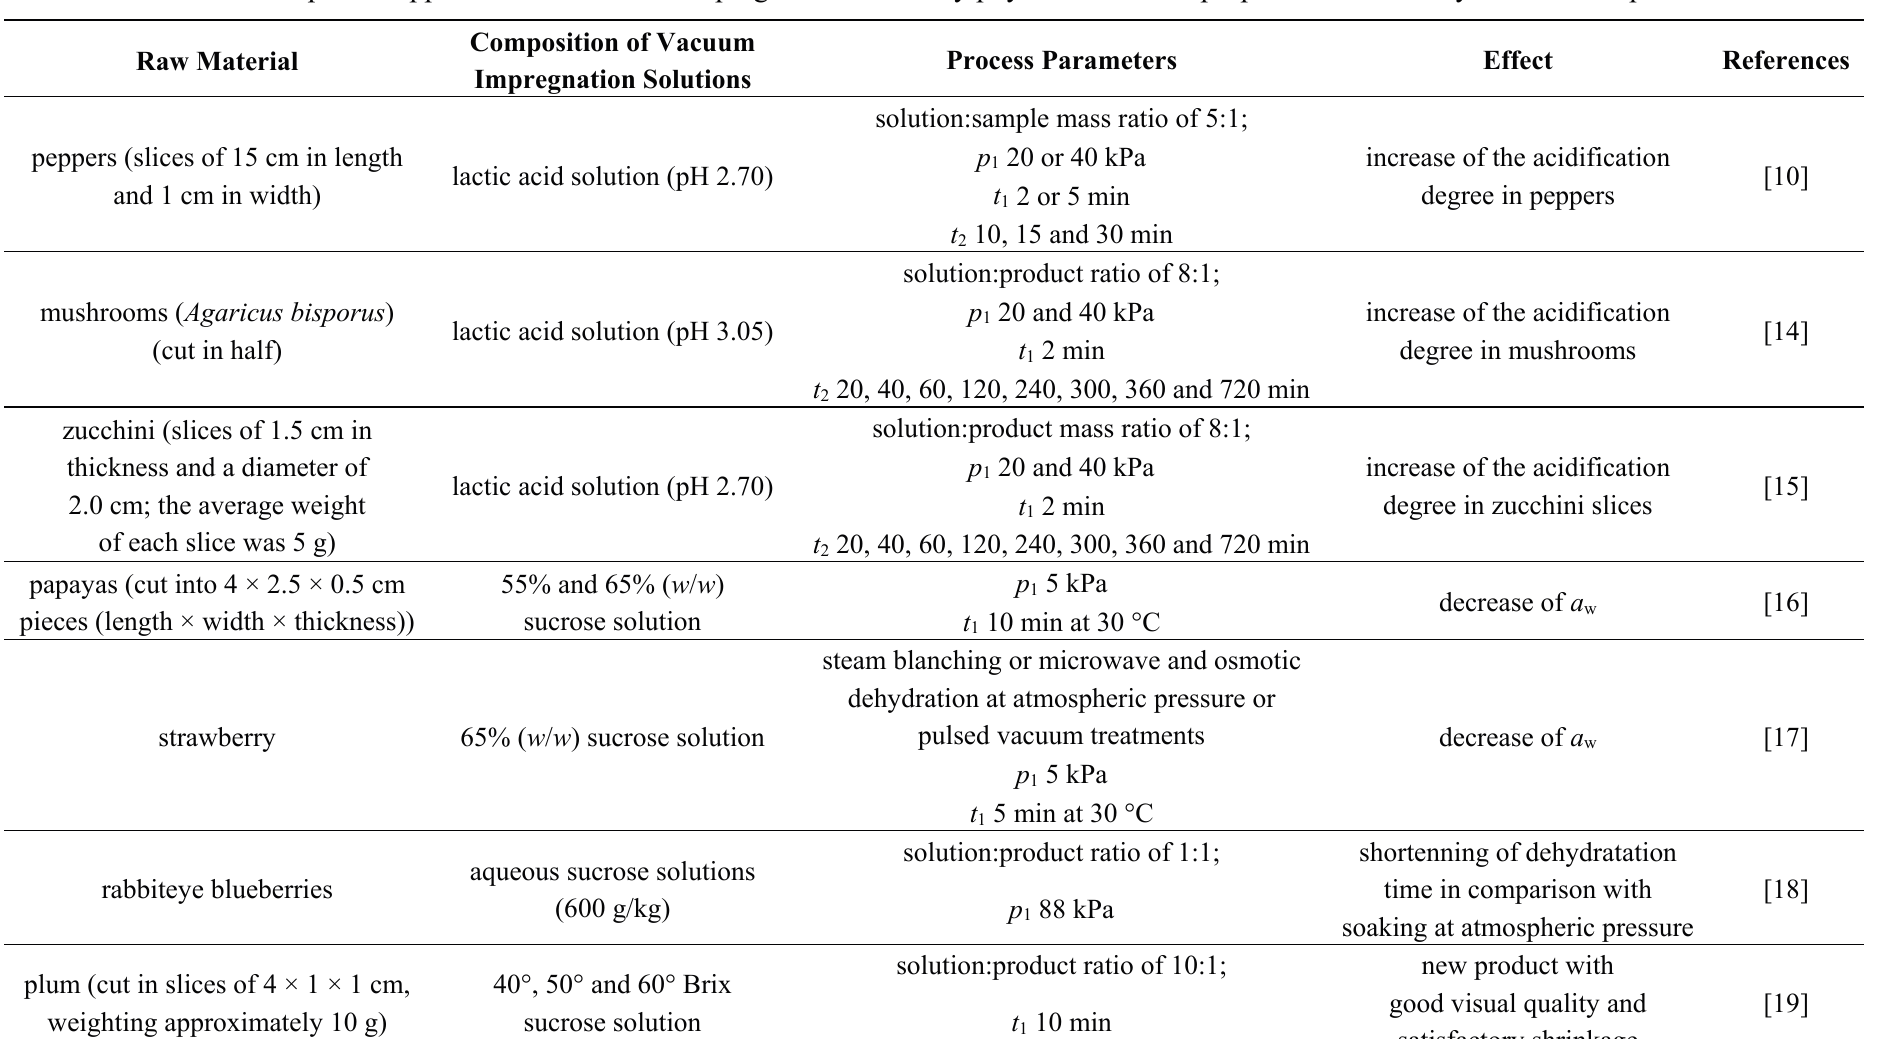
Table 1. Examples of applications of vacuum impregnation to modify physico–chemical properties and sensory attributes of